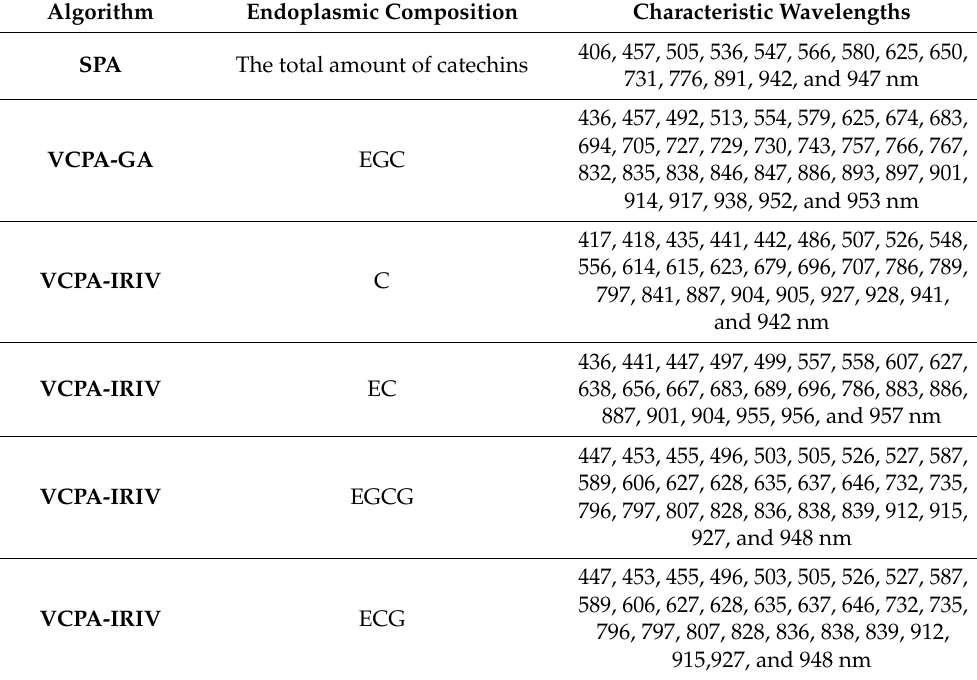
Table 1. The Characteristic wavelengths screened by different variable screening methods.